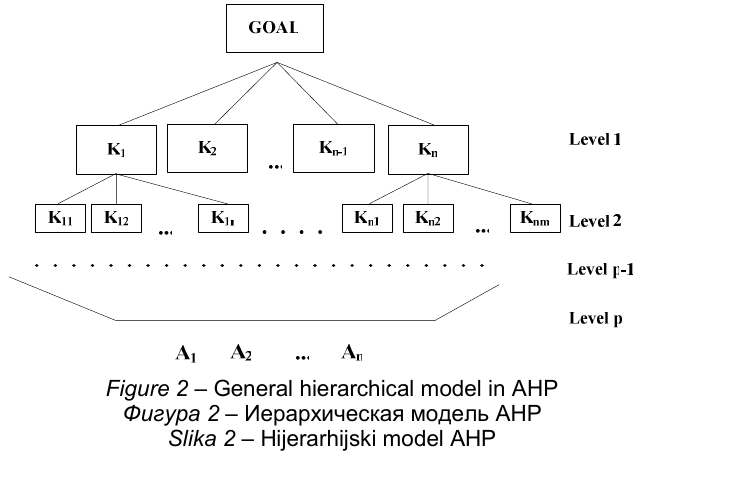
Figure 2 – General hierarchical model in AHP Фигура 2 – Иерархическая модель AHP Slika 2 – Hijerarhijski model